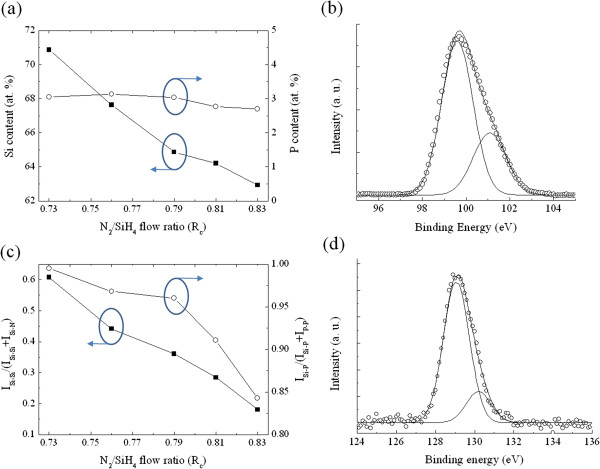
XPS analysis of P-doped Si-NCs/SiNxfilms. (a) Si and P concentrations in P-doped Si-NCs/SiNx films as a function of the Rc value. (b) Deconvolution analysis of a representative Si 2p XPS spectrum of the P-doped Si-NCs/SiNx sample with Rc = 0.79. (c) XPS peak intensity ratios of ISi-Si/(ISi-Si + ISi-N) and IP-P/(ISi-P + IP-P) of P-doped Si-NCs/SiNx films as a function of the Rc value. (d) Deconvolution analysis of a representative P 2p XPS spectrum of the P-doped Si-NCs/SiNx sample with Rc = 0.79.